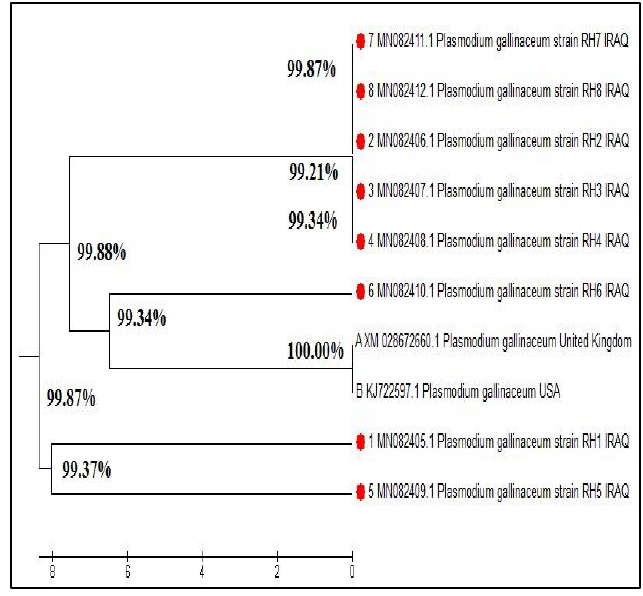
Figure 2. Neighborgoining tree plasmodium gallinaceum ama-1